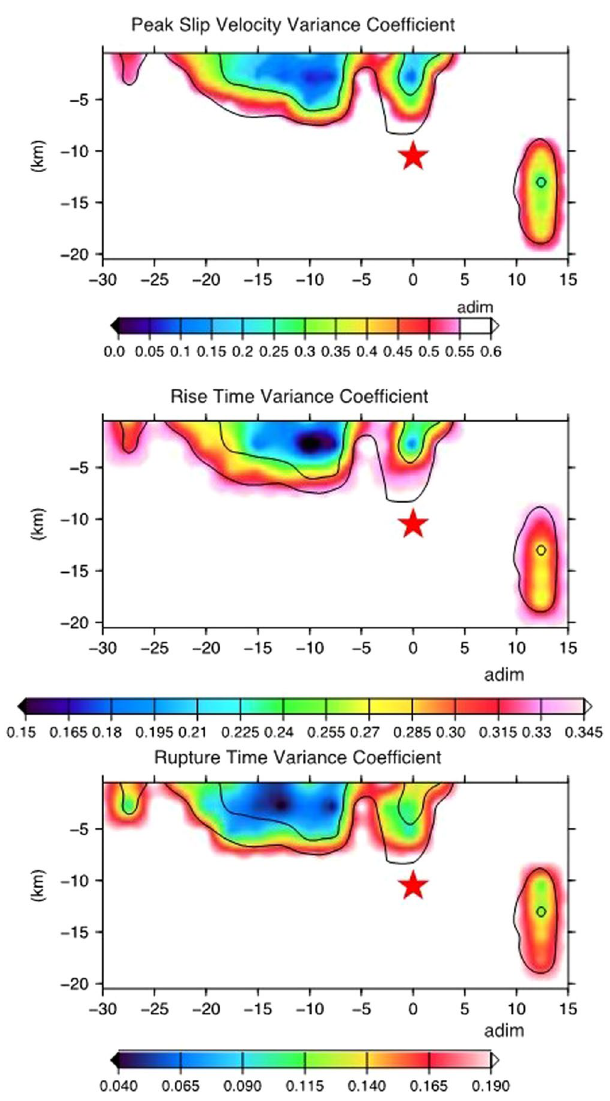
Figure 4. Coefficient of variation (CV). Variance coefficient distribution of peak slip velocity, rise time and rupture time (upper, middle, and bottom panel, respectively) of the 2015 Lefkada rupture model (Fig. 3a) computed through ensemble inference. Black contour lines show the fault region with a peak slip velocity greater than 0.9 and 1.8 m/s. The plot was created using the GMT (Generic Mapping Tools, http://gmt.soest. hawaii.edu/) software package 57 , version